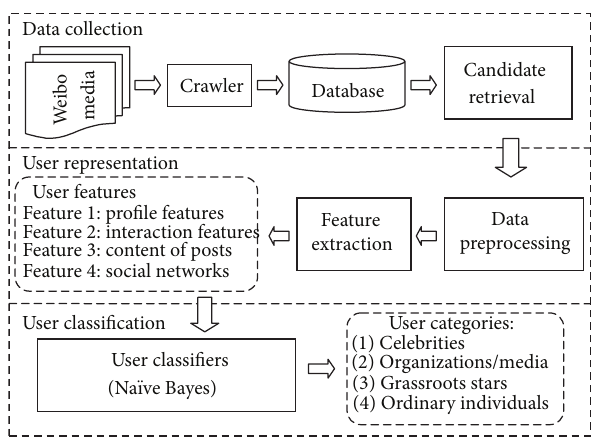
Figure 1: Event-based user classification analysis